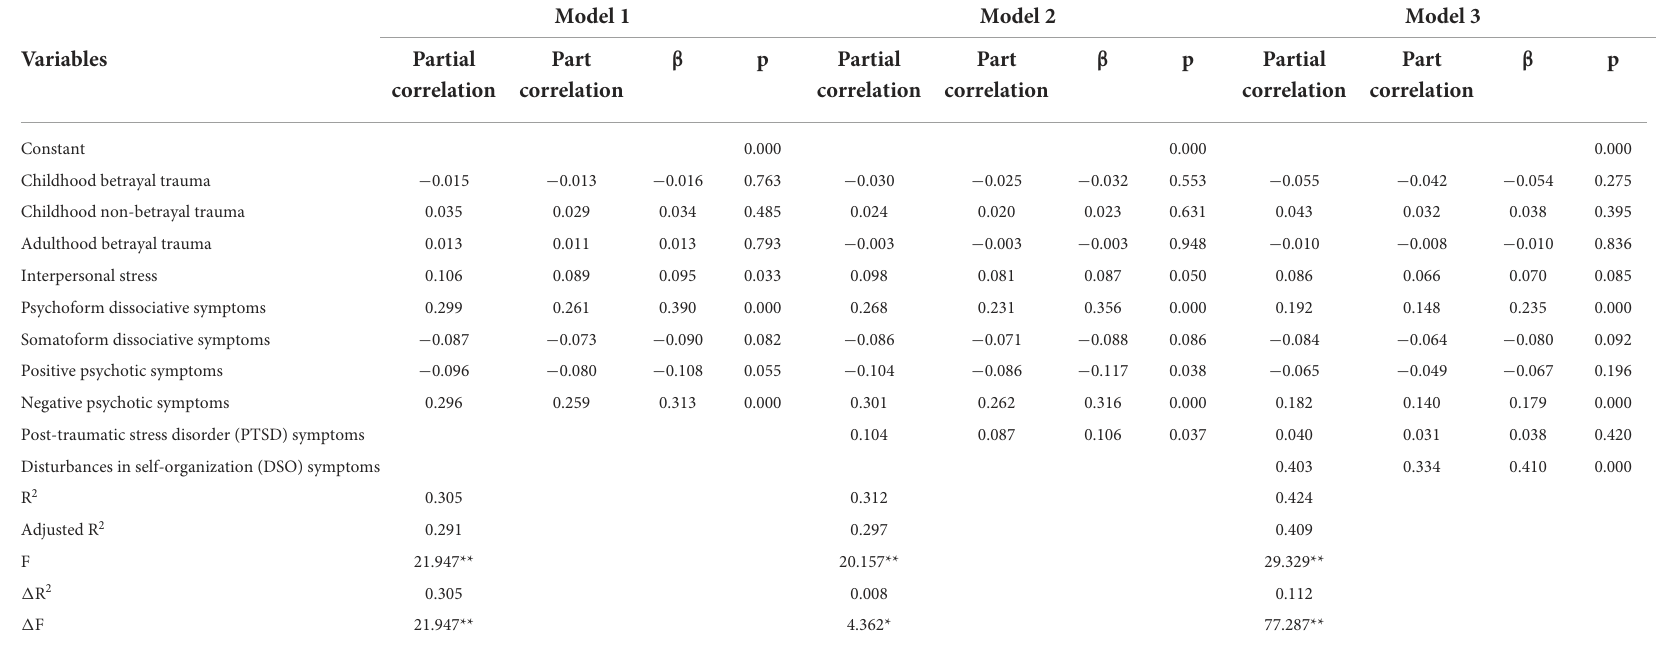
TABLE 4 Hierarchical multiple regression predicting depressive symptoms from post-traumatic symptoms (N =